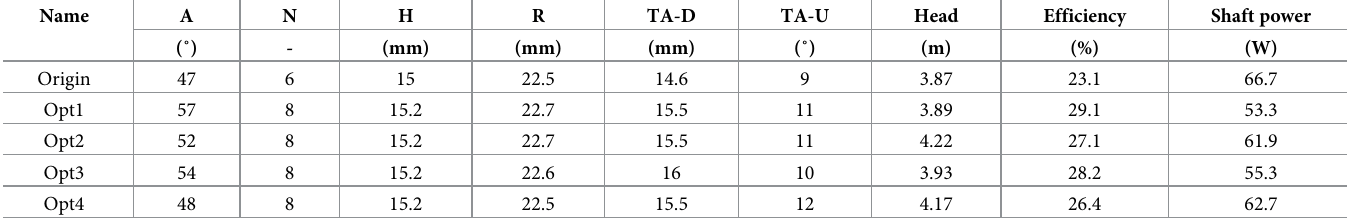
Table 6. Optimization results of engine cooling water